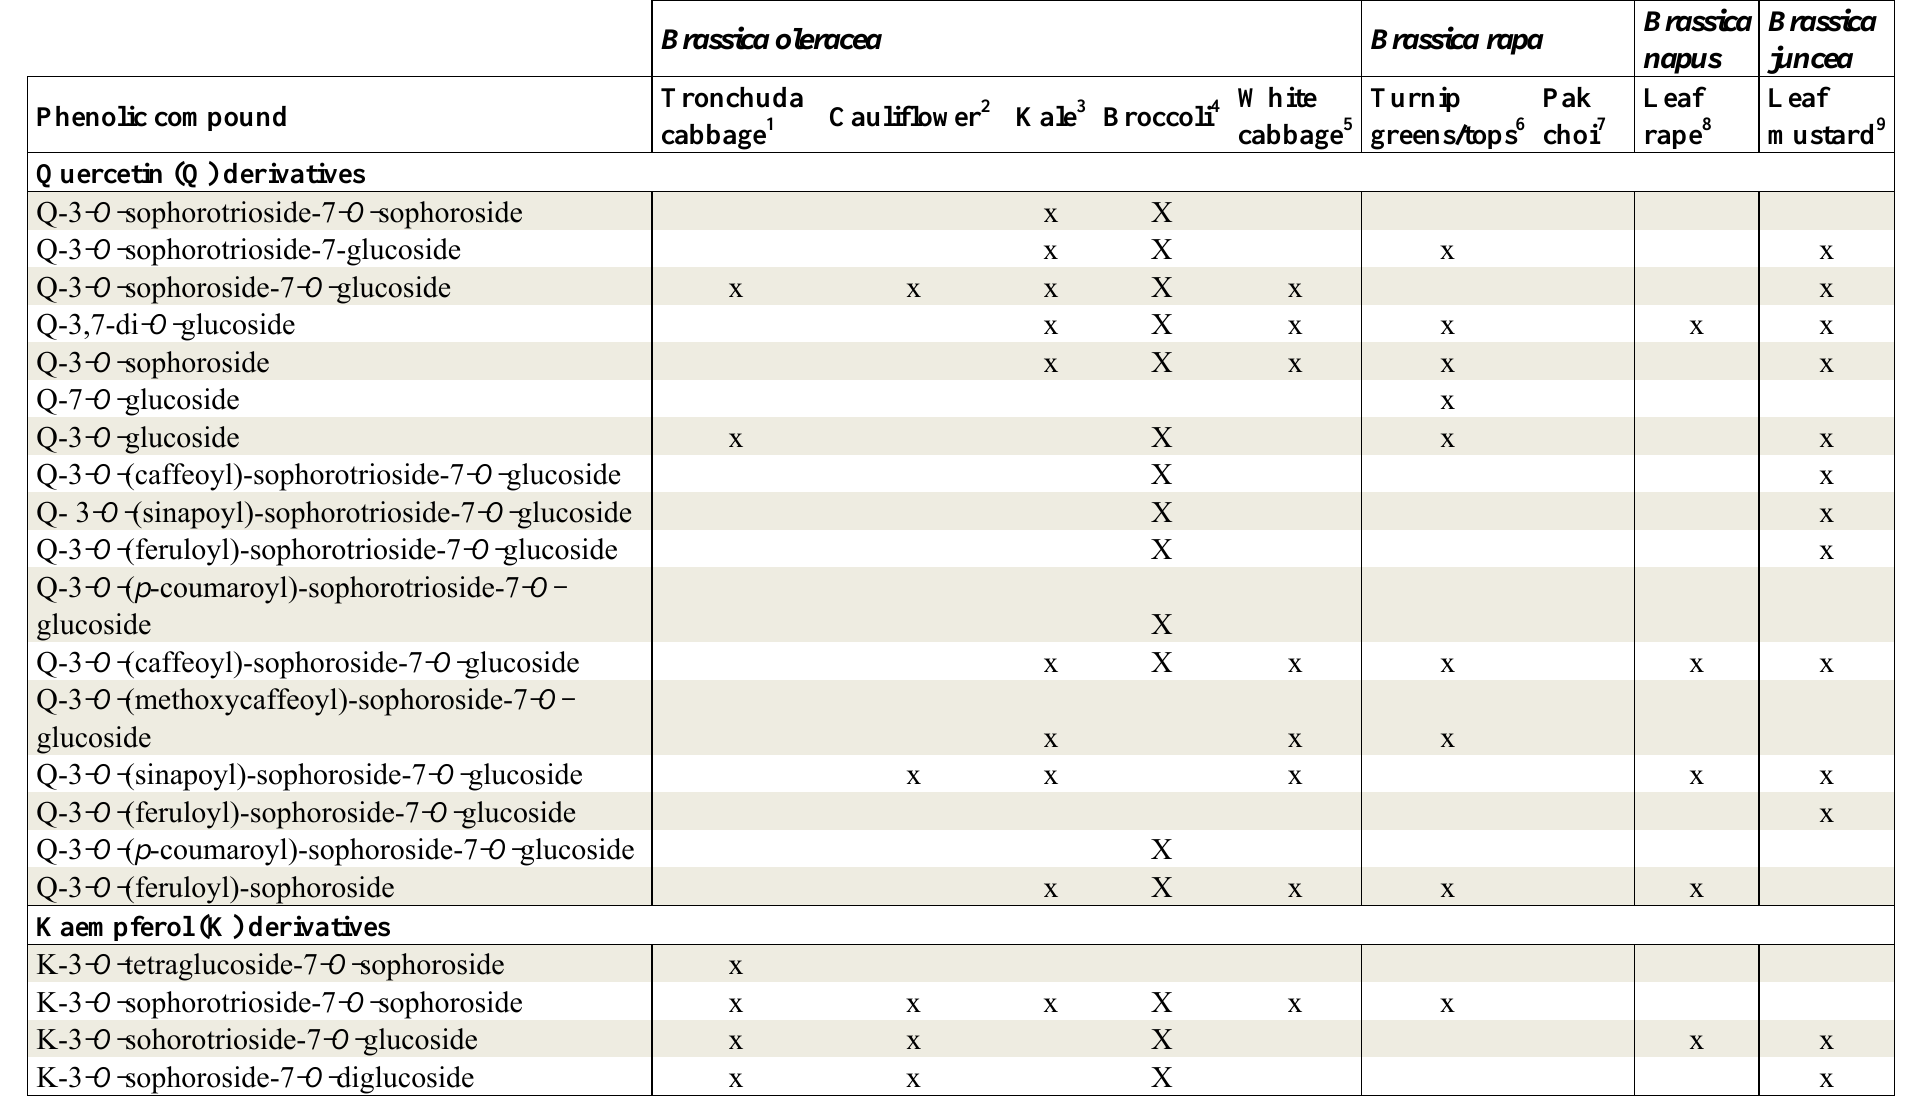
Table 2. Variation of phenolic compounds found in main vegetable Brassica